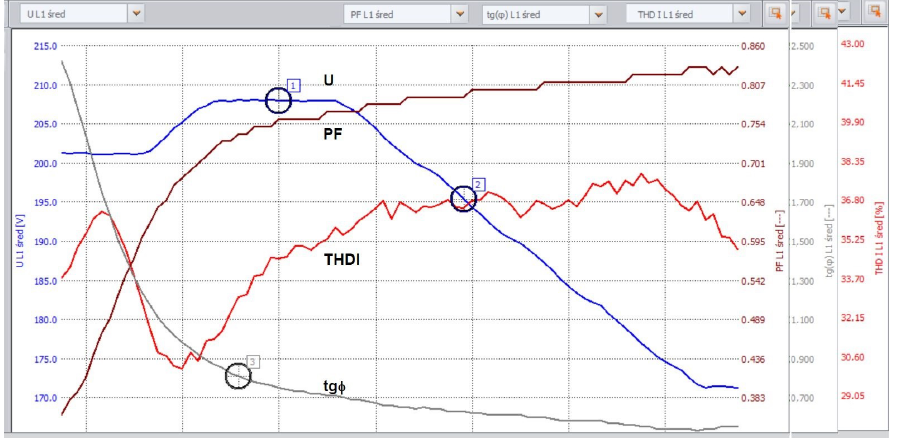
Figure 2. Characteristic of changes in voltage, total power factor, THDI and tg φ circuit 1 of the tested lighting installation—discharge